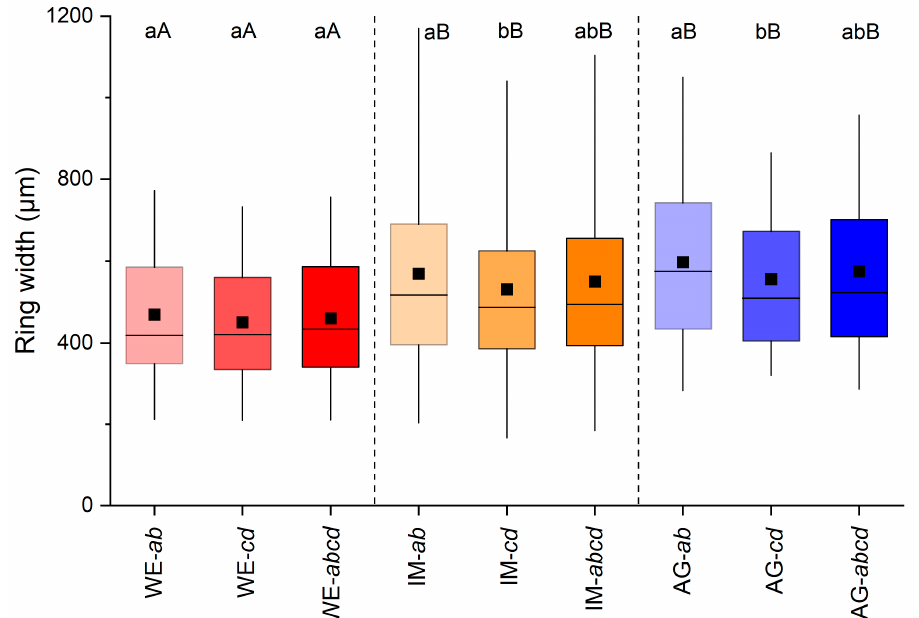
Figure 3. Box-plots showing variability in ring width among mean values of radii a and b (= ab ), mean of radii measured perpendicular to these radii (= cd ; cf. Figure 1) and all radii (= abcd ) of all shoots taken from one stock at a wind-exposed ridge (site WE), an intermediate site (IM) and a north-facing avalanche gully (site AG). Statistically significant differences of mean values between and within stocks are indicated by different capital and small letters, respectively ( p ≤ 0.05; Student’s t -test). For details on box-plots, see Figure 2. Figure 4a–f. The highly signi fi cant agreement ( p ≤ 0.001) in ring width variations of radius a and b and c and d (i.e., ab : cd ), are striking (Figure 4a–c). Mean t BP -scores for all radius comparisons in all individuals were more than twice as high as the value of 3.5, indicating highly secure cross-dating.